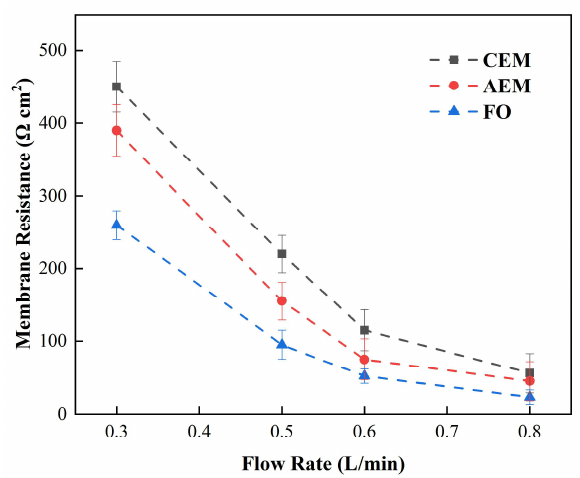
Figure 4. Relationship between the measured impedance and solution flow rate under the condition of DC (0.05 M NaCl).